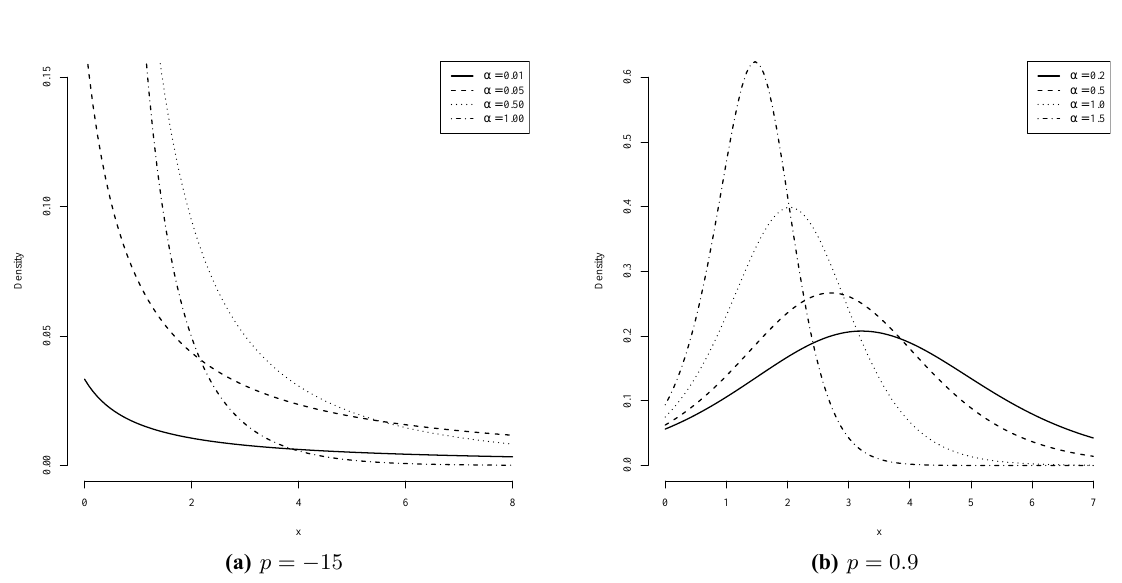
Figure 1 - The NHG density function for some parameter values; λ = 1